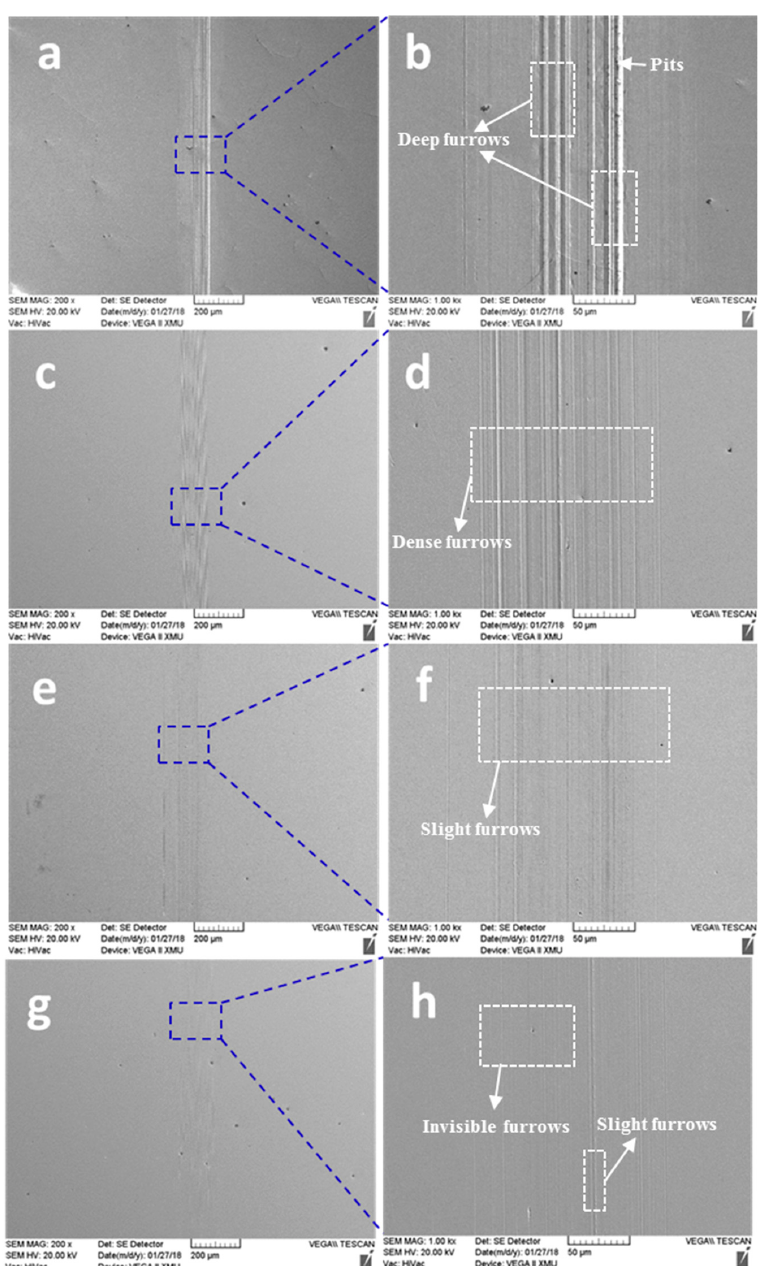
Figure 5. SEM wear images of wear scars after tests using different concentrations of paroline oils: ( a ) pure paroline oil; ( b ) paroline oil with 0.1 wt.% QDs; ( e ) paroline oil with 0.3 wt.% QDs; ( g ) paroline oil with 0.5 wt.% MoS 2 QDs. ( b , d , f , h ) are the local enlarged drawings of ( a , c , e , g ), respectively.